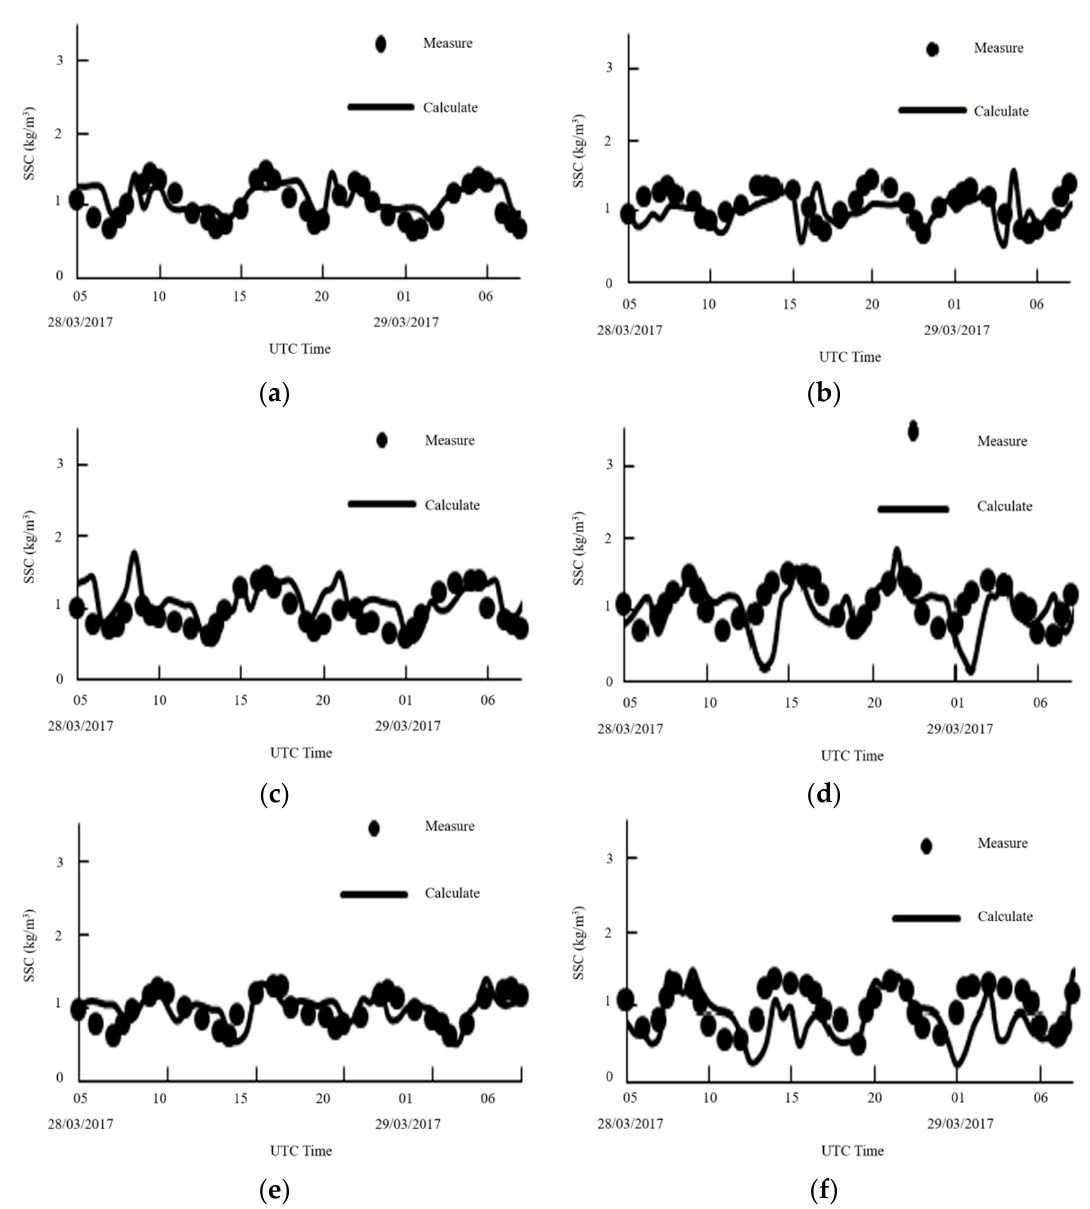
Figure 8. Model and measure of SSC data at six stations. ( a ) SW1 station, ( b ) SW2 station, ( c ) SW3 station, ( d ) SW4 station, ( e ) SW5 station, ( f ) SW6 station.